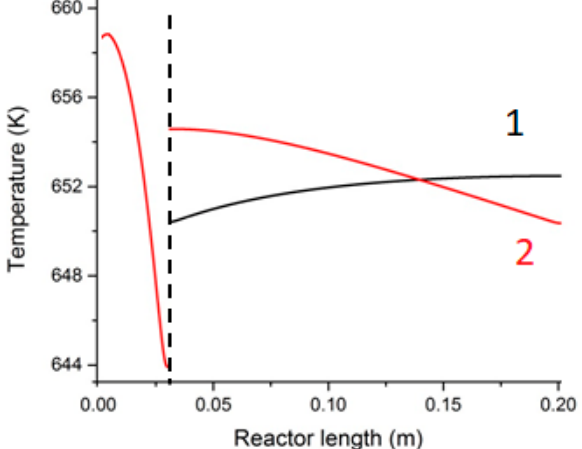
Figure 8. Temperature profiles in the catalyst, as a function of the flow configuration in the second reaction section of the MRHE. First section: counter-current flow. Second section: 1—co-current flow, 2—counter-current flow. Reactant velocity: 2.71 × 10 − 2 m s − 1 . Coolant velocity in each section: 9.0 × 10 − 2 m s − 1 . Reactant inlet temperature: 473 K. Coolant inlet temperature: 498 K. Distance a = 1.5 mm.